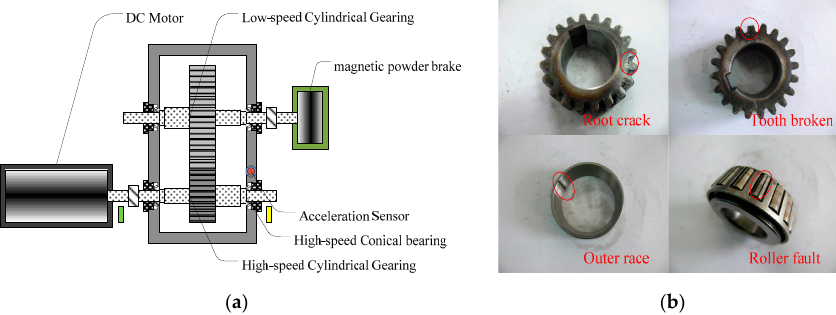
Figure 13. The single-stage cylindrical straight gearbox test rig: ( a ) Schematic diagram of gearbox test rig; ( b ) The damaged components.